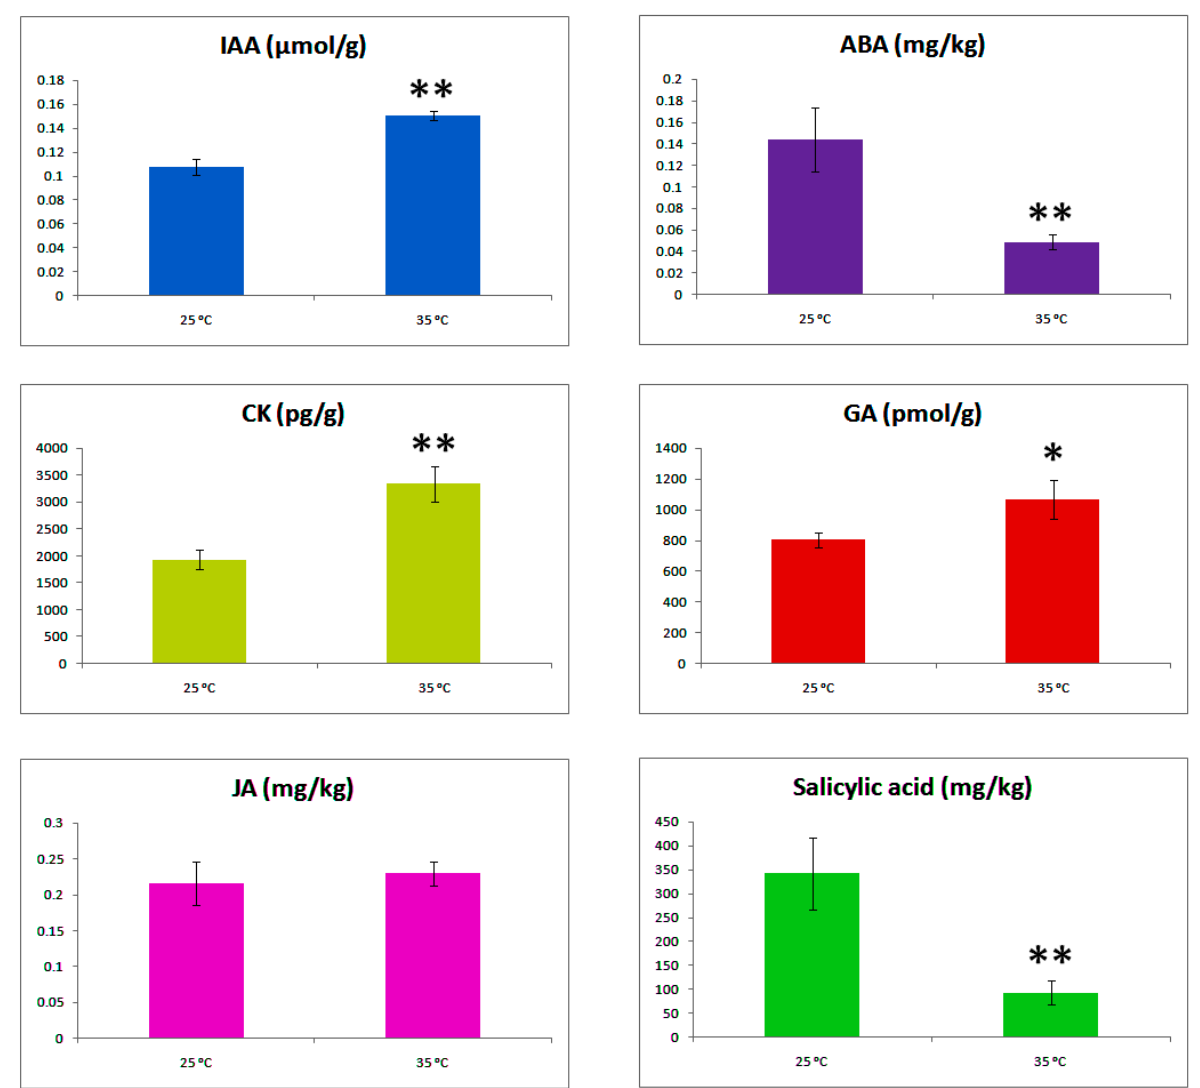
Figure 5. Concentrations of phytohormones in top axillary buds under 25 ◦ C and 35 ◦ C conditions during bud formation stage. IAA (indole acetic acid), CK (cytokinins), JA (jasmonic acid), ABA (abscisic acid), GA (gibberellic acid) and Sa (salicylic acid). Data are shown as mean ± SE of three biological replicates with forty-five axillary buds for each single repeat. Asterisks represent significant differences between the treatment conditions 25 ◦ C and 35 ◦ C at * p < 0.05 and ** p < 0.01 level.